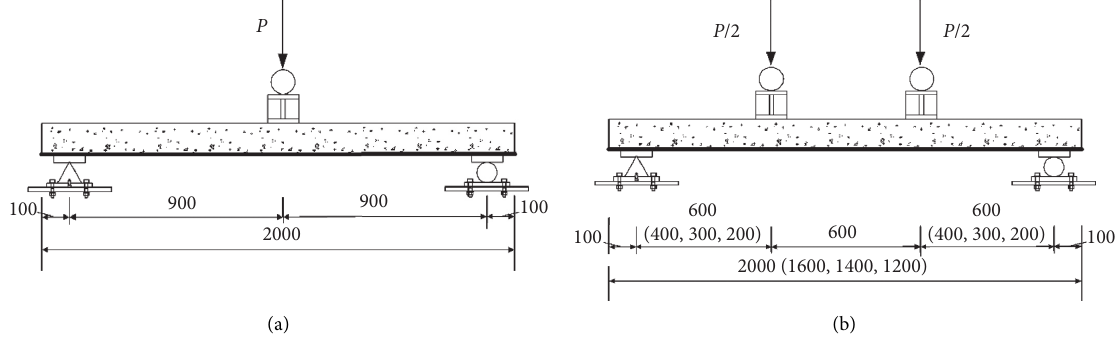
Figure 5: Loading configurations for tested specimens (unit: mm). (a) HSC2-1. (b) HSC1-1 ∼ HSC1-5, and HSC2-2 ∼